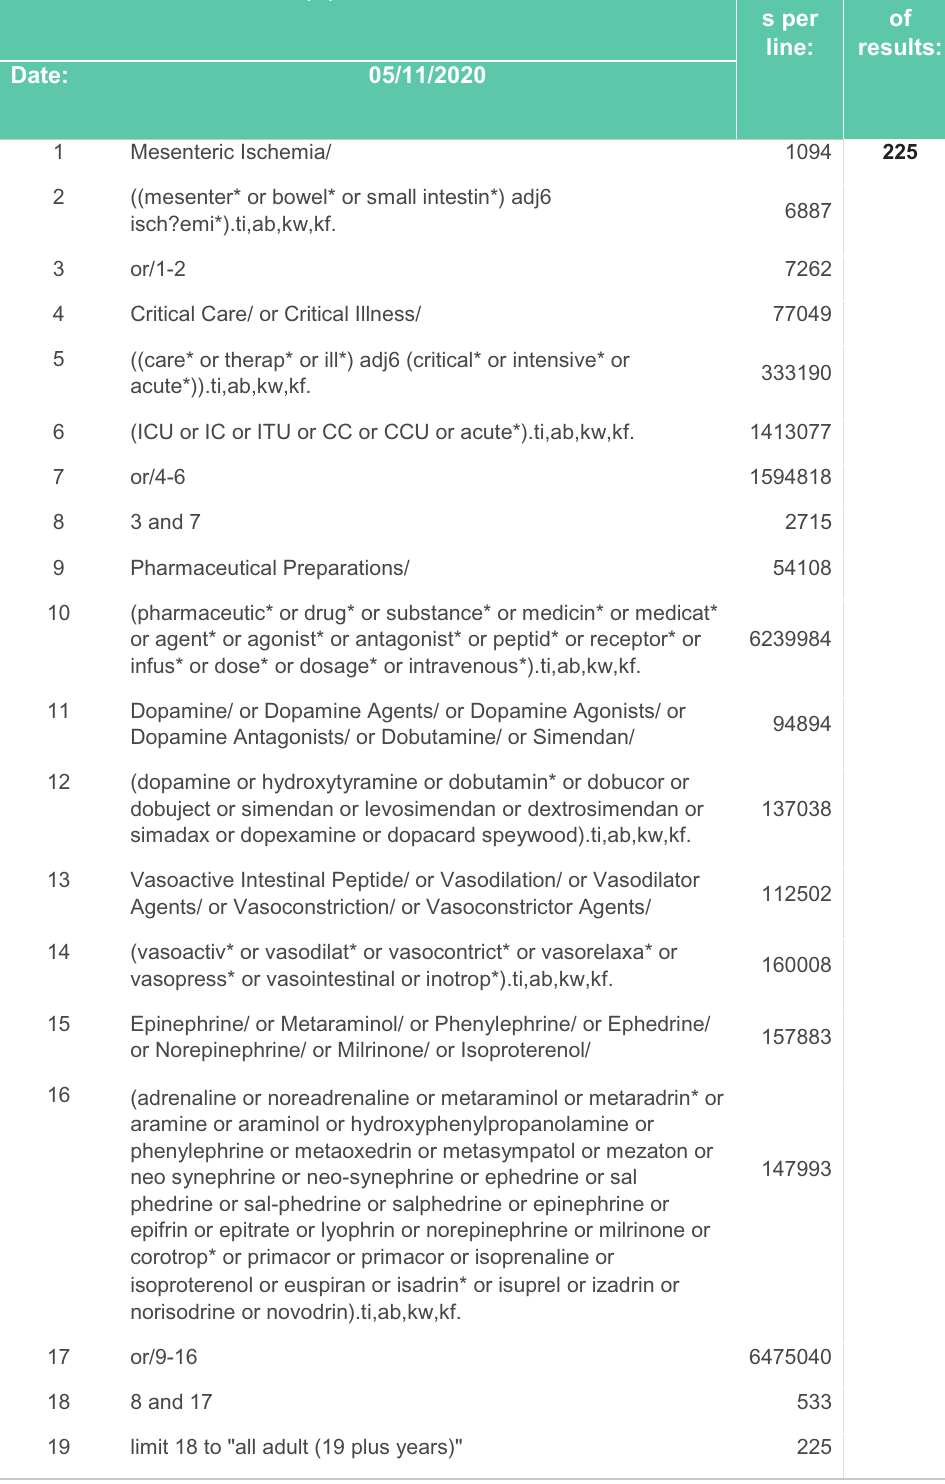
Figure 2. Search strategy –